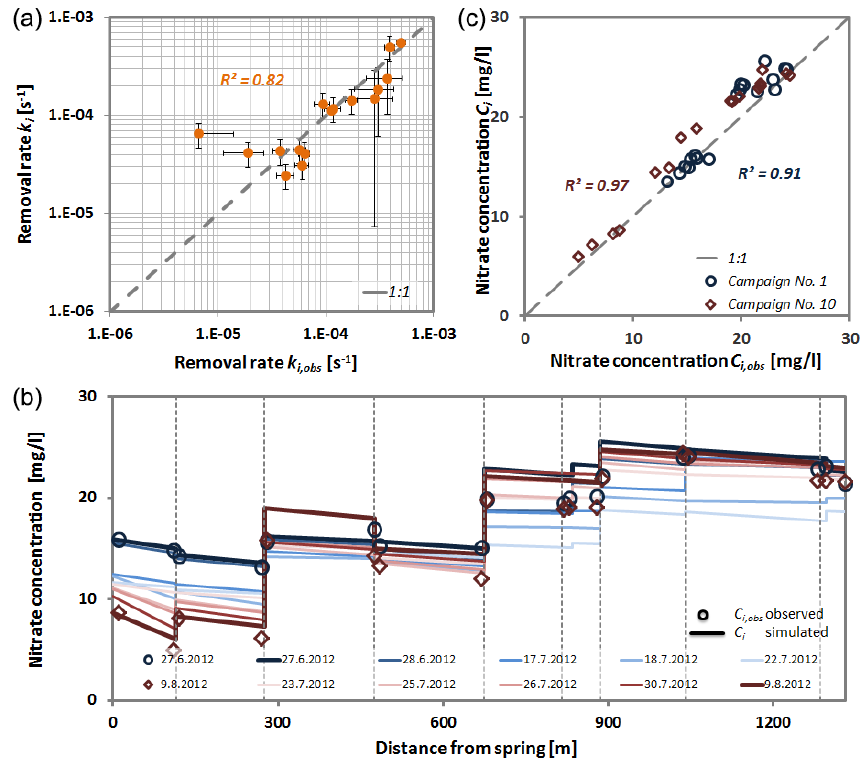
Figure 4. (a) Estimated ( k i ) and empirical ( k i, obs ) in-stream nitrate removal rates. (b) Observed ( C i, obs symbols) and calculated ( C i lines) in-stream nitrate concentration patterns for all days. Sampling campaigns No. 1–No. 10 are colour-coded from blue to red. Dashed lines symbolize the positions of the drainpipes. (c) Comparison of modelled and observed in-stream nitrate concentrations for campaigns No. 1 (blue circles) and No. 10 (red